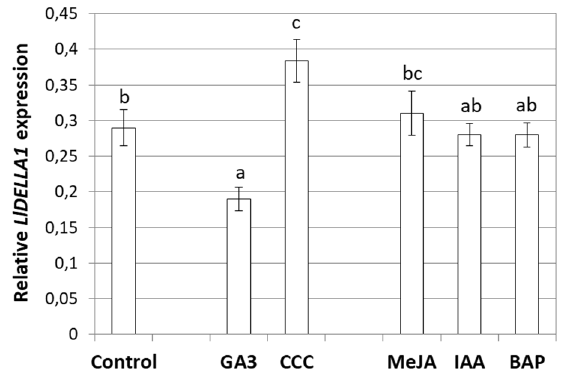
Figure 8. Expression profile of LlDELLA1 in yellow lupine flowers after different compound treatments. GA 3 —gibberellic acid, CCC—chlorocholine chloride, MeJA—methyl jasmonate, IAA— indole-3-acetic acid, BAP—6-benzylaminopurine. The transcriptional activity of LlDELLA1 was measured in three independent biological replicates and three technical replicates ( n = 9); ± SE is